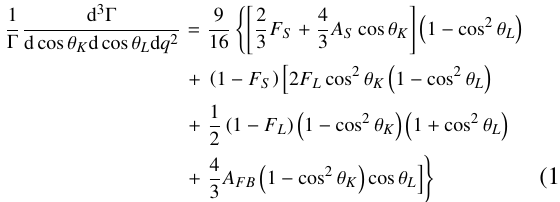
to validate the fit and to estimate the F S and A S con- tributions to be used in the signal q 2 bins. The S- wave fraction is measured to be F S = 0 . 01 ± 0 .